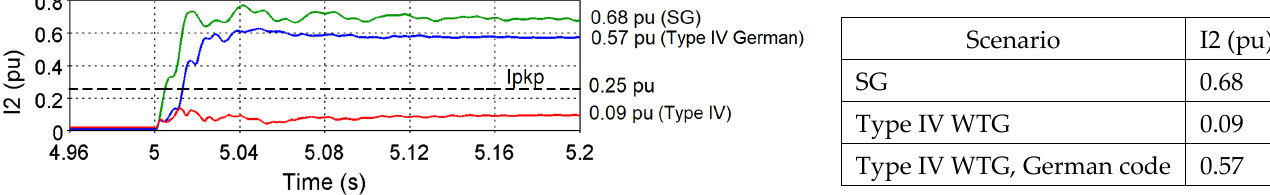
Figure 7. Negative-sequence fault current due to fault AG1 under SG (green), Type IV wind turbine generator (WTG) with no I2 control (red), and Type IV WTG under the German grid code (blue).